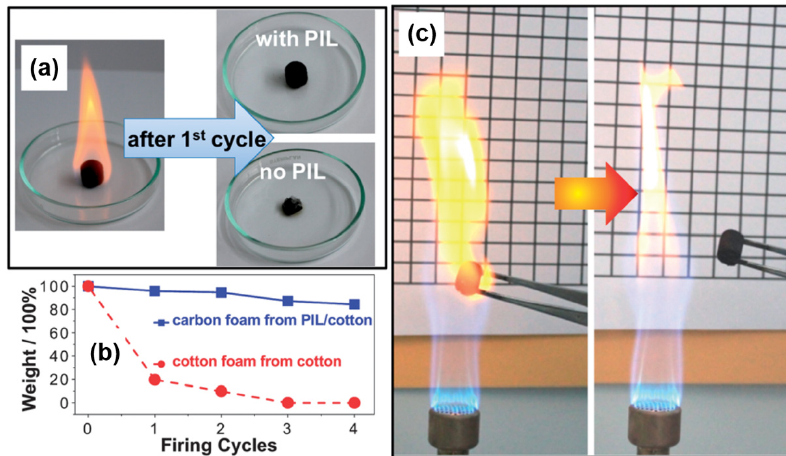
Figure 15. ( a ) Photographs of the 1st firing cycle test of the carbon foams (absorb 500 wt % of ethanol and burn in air): ( Left ) a burning ethanol ‐ wetted foam and ( Right ) foams after the 1st firing cycle test. ( b ) Plot of the carbon foam mass vs. the firing cycle. ( c ) Photographs illustrating the fire ‐ retardancy of a carbonaceous foam by repeatedly firing the sample using a butane/propane gas burner. Reproduced with permission of Ref. [217] (Copyright the Royal Society of Chemistry 2015).